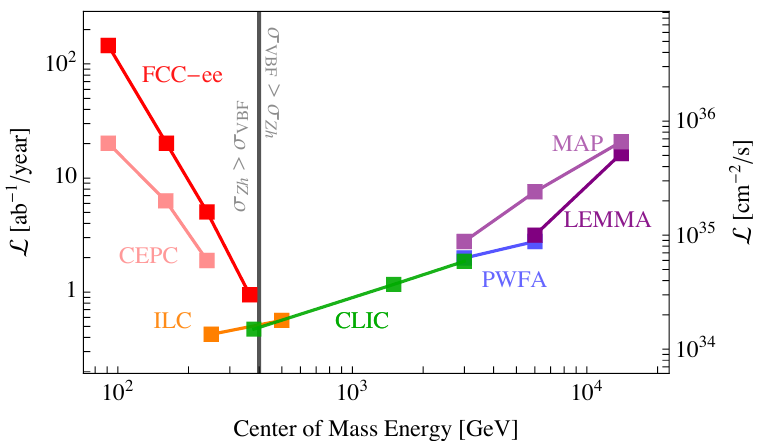
Figure 1. Various proposals for future lepton colliders as a function of center-of-mass energy and instantaneous luminosity L , where we have assumed one interaction point for the linear ones (ILC, CLIC, PWFA) and two for the circular ones (FCC-ee, CEPC, LEMMA, MAP). The total integrated luminosity can be obtained multiplying the left axis by the years of run and by the fraction of a year in which a machine will be running. The luminosities reported correspond to luminosities at the peak of energy only for circular colliders. On the left/right of the vertical grey line the Higgs-strahlung rate is larger/smaller than the vector boson fusion